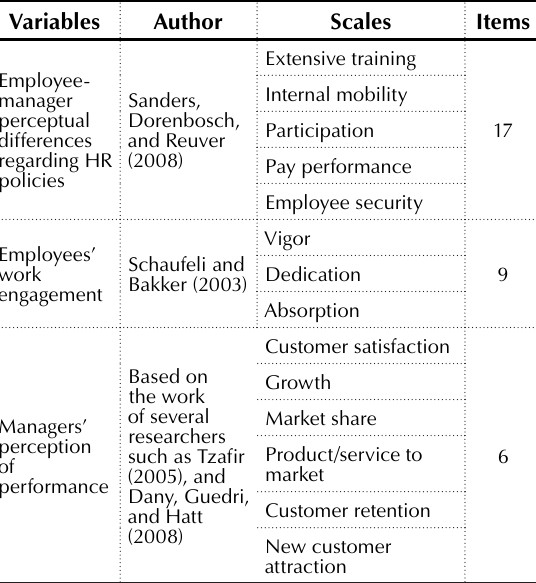
Table 1. Operationalization of the research variables